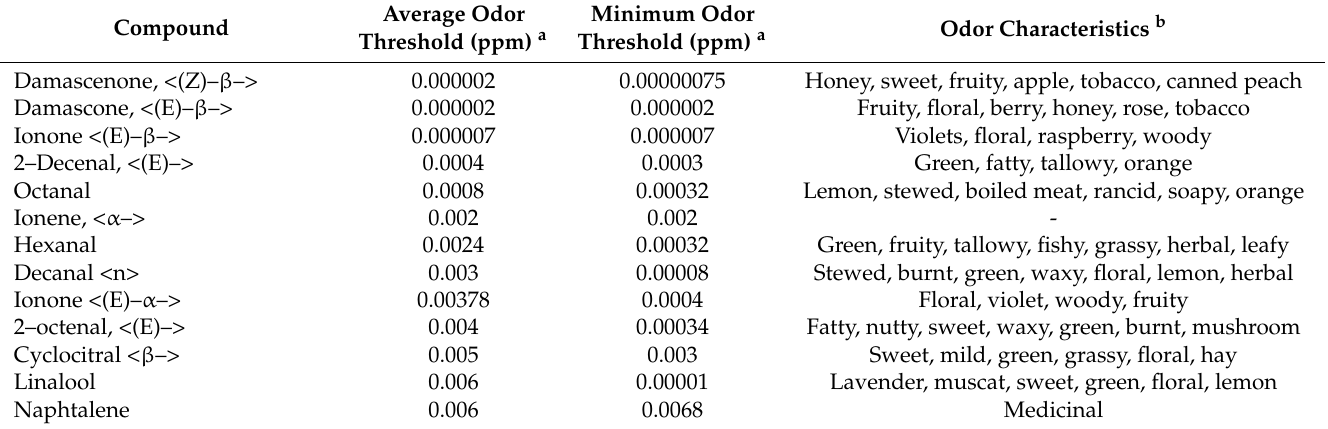
Table 6. Odor thresholds and characteristics of the identified compounds.